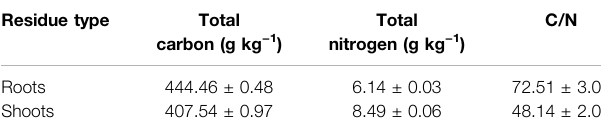
TABLE 2 | Basic characteristics of maize residues.